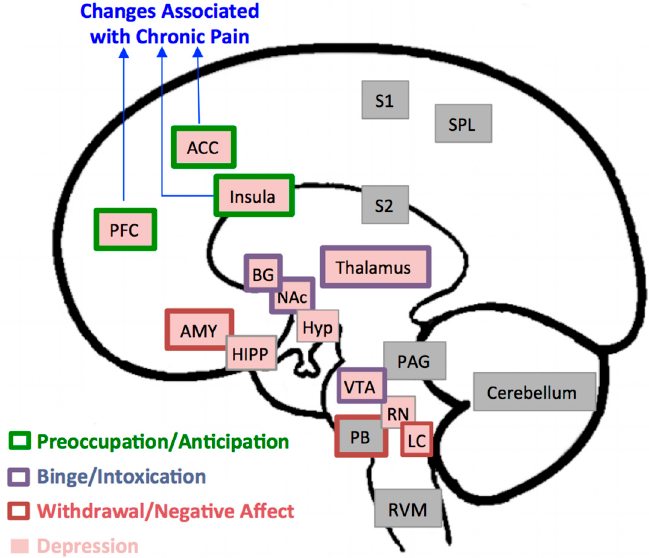
Figure 1. Brain Regions Implicated in Pain, Depression, and Alcohol Addiction. In this model, brain regions implicated in pain processing include the prefrontal cortex (PFC), anterior cingulate cortex (ACC), insula, thalamus, basal ganglia (BG), amygdala (AMY), parabrachial nucleus (PB), periaqueductal gray (PAG), rostroventral medulla (RVM), primary and secondary sensory areas (S1, S2), superior parietal lobe (SPL), and cerebellum [20]. Structural, functional, and metabolic changes